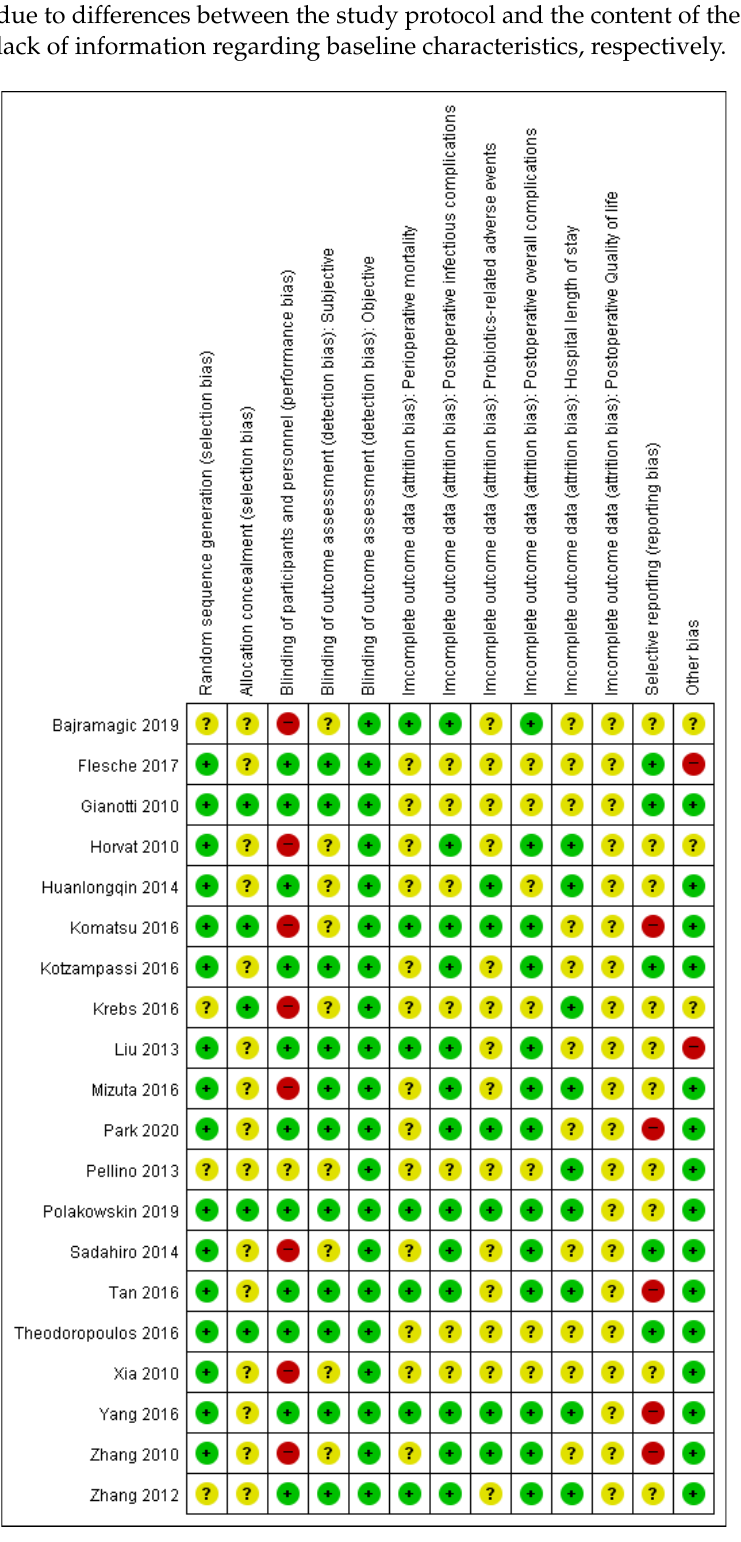
Figure 2. Risk of bias summary: Review authors’ judgements about each risk of bias item for each included study. Subjective outcomes: perioperative mortality and hospital length of stay. Objective outcomes: postoperative infectious complications, probiotics-related adverse events, postoperative overall complications, and postoperative quality of life. Categories: Green point (+) = low risk of bias; yellow point (?) = unclear risk of bias; red point (−) = high risk of bias.